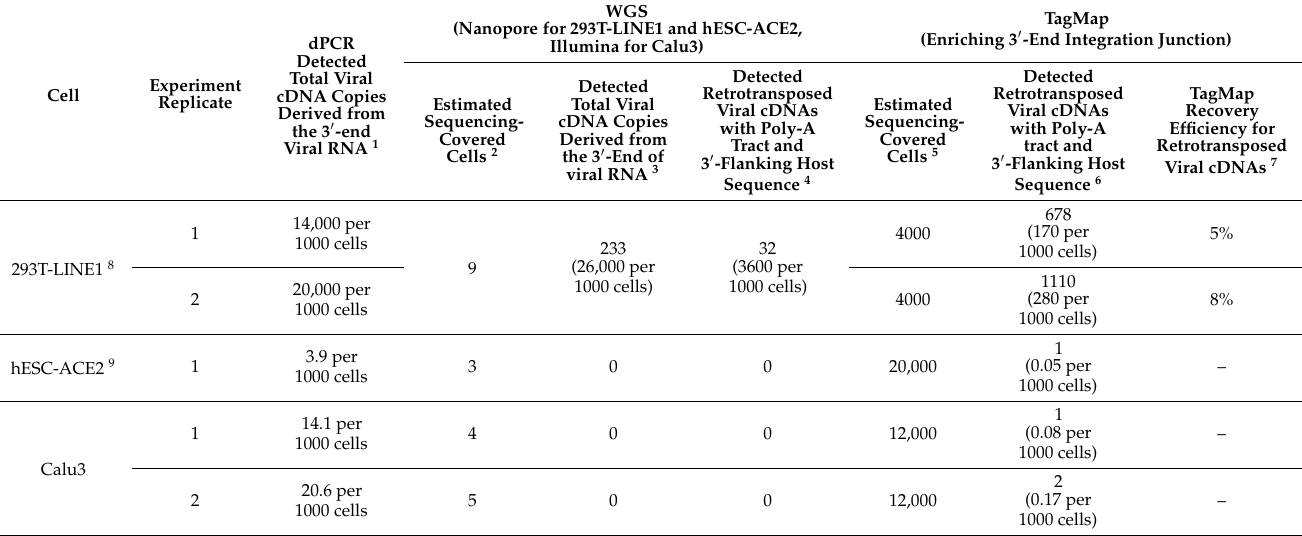
Table 1. Method comparison for detecting and quantifying reverse transcribed and retrotransposed SARS-CoV-2 cDNA in virus-infected